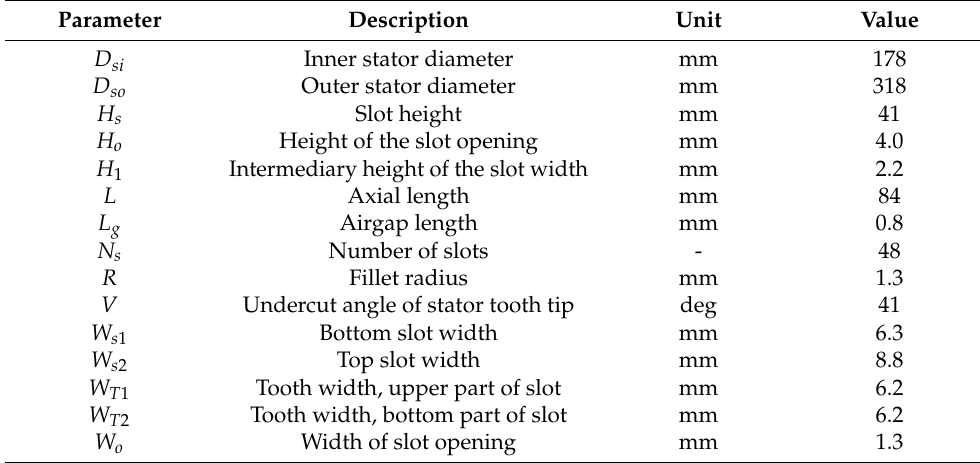
Table 1. Main stator parameters.